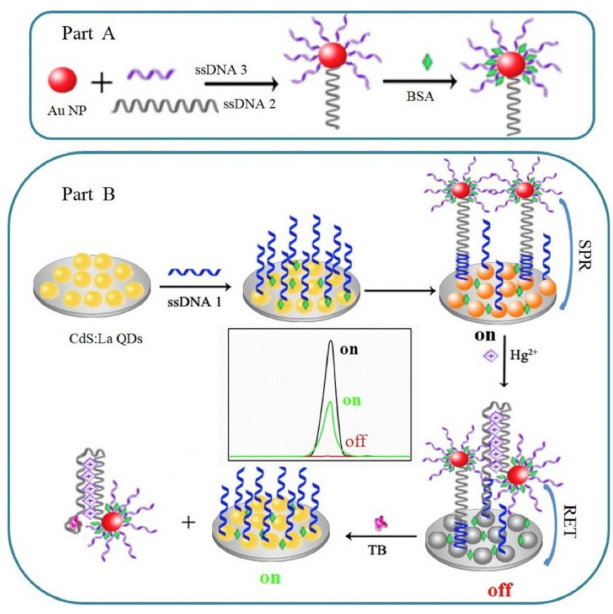
Figure 8. Fabrication of the ECL-RET aptasensor for Hg 2+ and TB, respectively based on the resonance energy transfer between CdS:La QDs film and AuNPs; ( A ) Preparation of aptamer probe; ( B ) Electrode surface modification and sensor reaction principle. Reprinted with permission from ref.